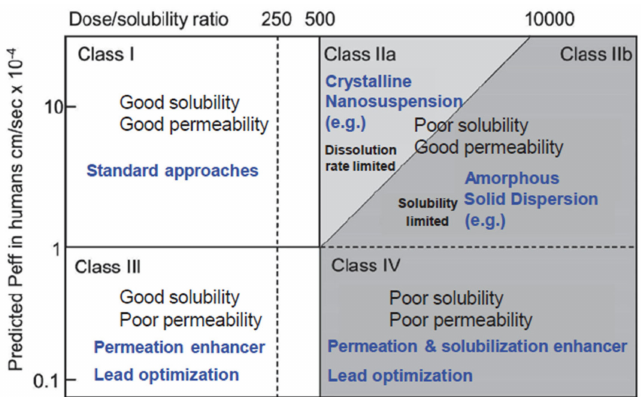
Figure 2. Modified biopharmaceutical classification system (BCS) including the division of class II in a dissolution rate limited partition for which nanotechnological approaches may be feasible (class IIa) and one that is solubility limited for which amorphous solid dispersions are most promising as drug delivery strategy (adapted with permission from [16], Springer Nature, 2015). Peff denotes average human jejunal